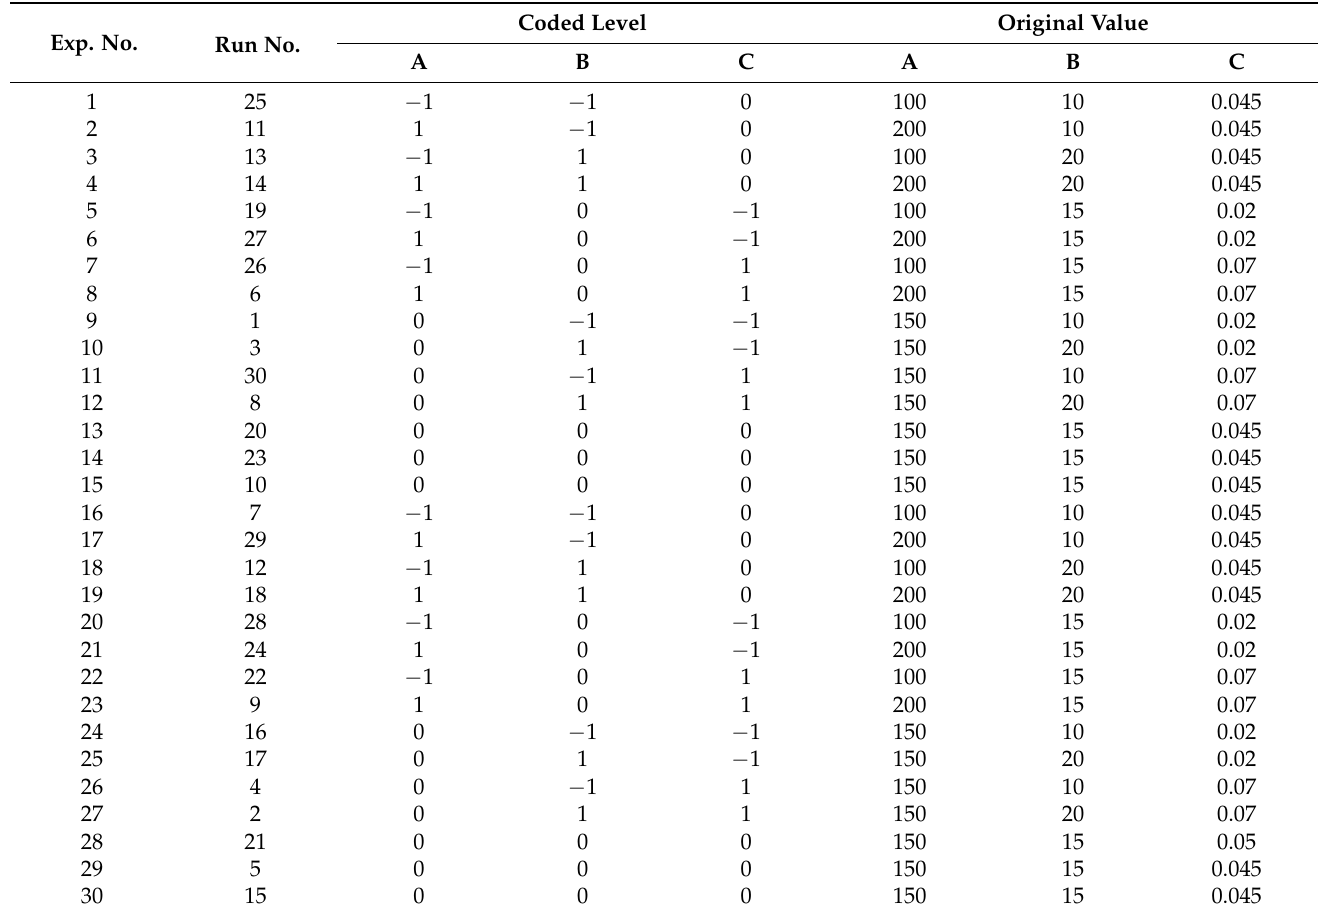
Table 2. The design of the experiment using Box-Behnken design. Exp.